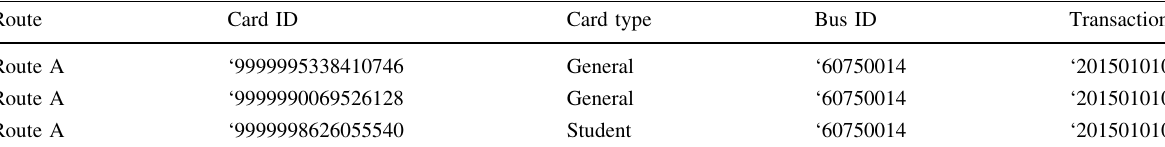
Table 2 A sample of the smart card raw data Route Card